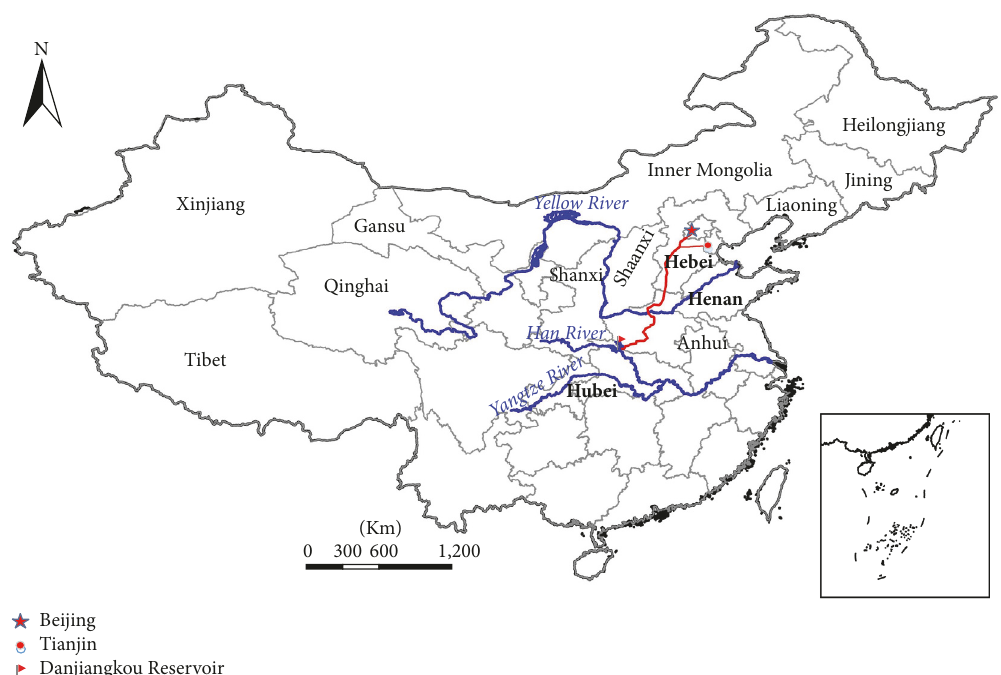
Figure 2: Schematic figure of the main provinces and the central route (red line) of the SNWT